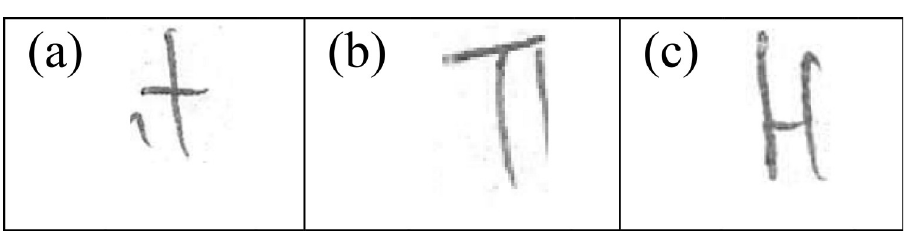
Fig 4. Characteristic handwritten allographic features from writers from Chinese vernacular